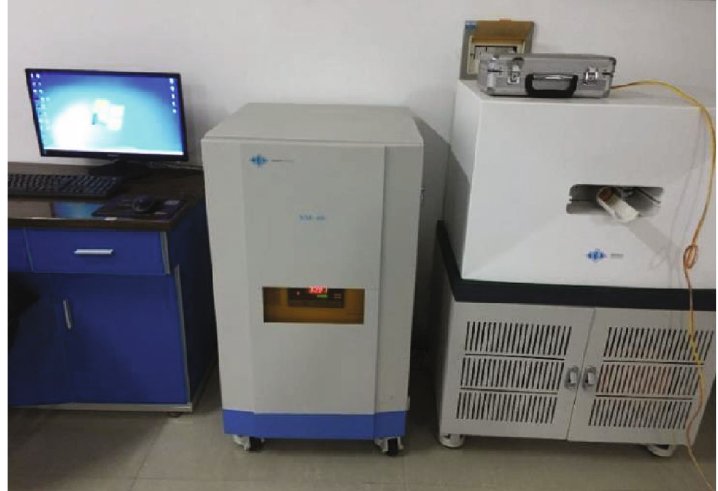
Figure 3: Low fi eld